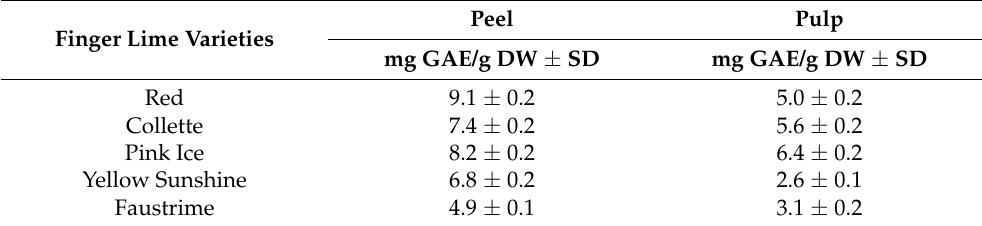
Table 1. Total polyphenol content (TPC) of Citrus australasica peel and pulp extracts, expressed as mg of gallic acid equivalents (mg GAE) for mass of dry weight (g DW) ± standard deviation (SD). Finger Lime